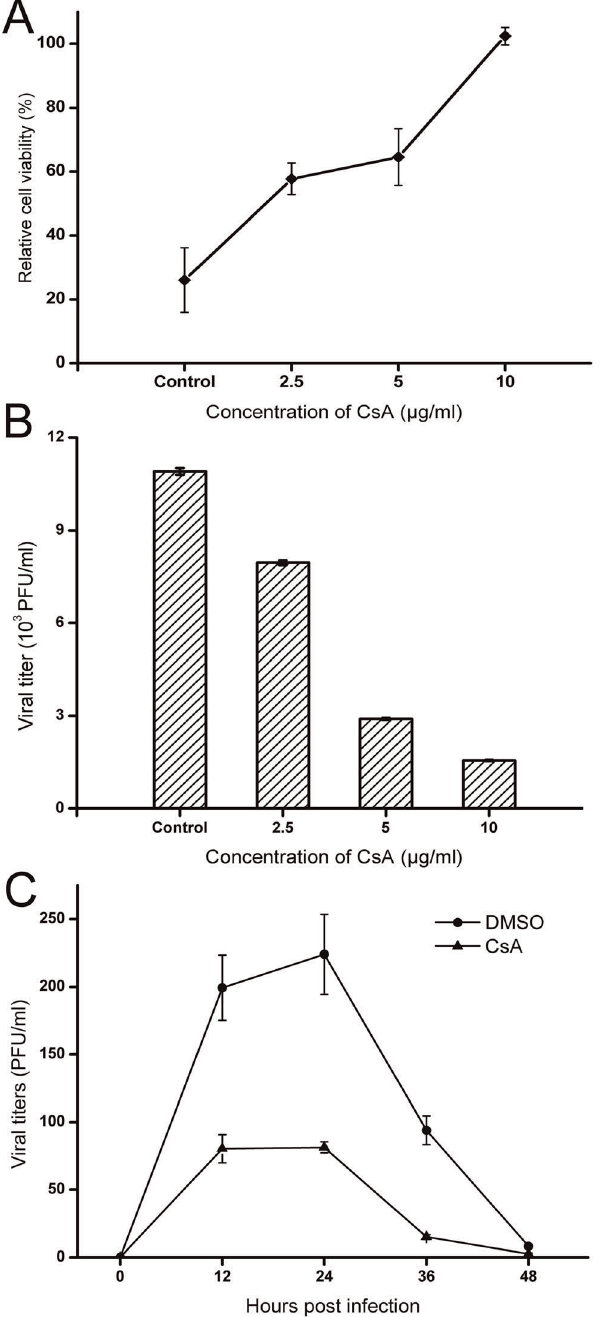
Figure 1. CsA inhibited the influenza virus replication in MDCK cell line. A: Cytopathic effect assay of CsA on the influenza virus replication. Monolayers of MDCK cells on 96-well microwell plates were infected with influenza A/WSN/33 (MOI=0.1). Infected cells were treated in duplicate with different concentrations of CsA (Control, 2.5 m g/ml, 5 m g/ml, 10 m g/ml) in DMEM with 2 m g/ml TPCK-treated trypsin, and the preparations were incubated at 37 u C for another 36 h, after which the monolayers were stained with crystal violet (0.1% in 20% ethanol) and examined for cytopathic effect (CPE). Data are presented as the mean plusminus standard deviation ( 6 SD) from three independent experiments. B: Plaque assay of the titer of viruses in the supernatant with different concentrations of CsA (0–10 m g/ml). Infected cells were treated in duplicate with different concentrations of CsA (0 m g/ml, 2.5 m g/ml, 5 m g/ml, 10 m g/ml) in DMEM with 2 m g/ml trypsin,